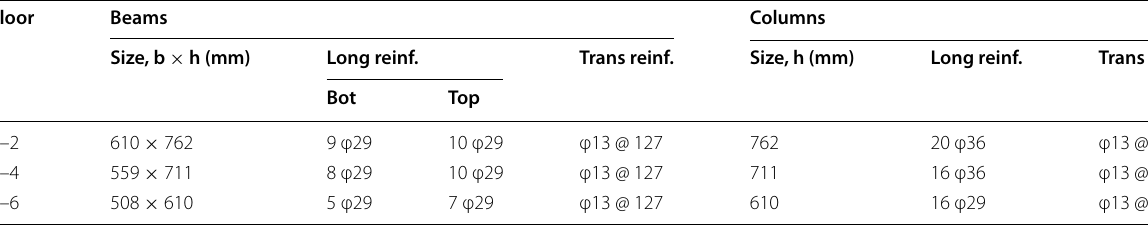
Table 1 Section and reinforcement